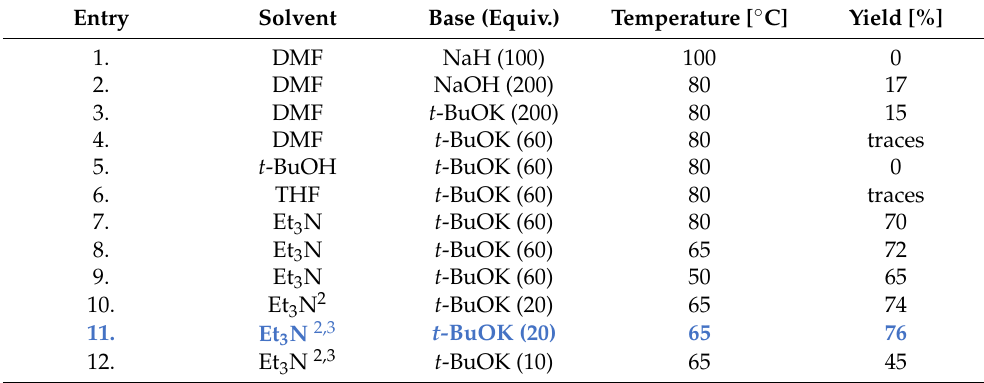
Scheme 3. Optimisation of S N Ar reaction on model compounds. Table 1. Optimisation of S N Ar reaction between model porphyrin 2a and carbohydrate 3a 1 .